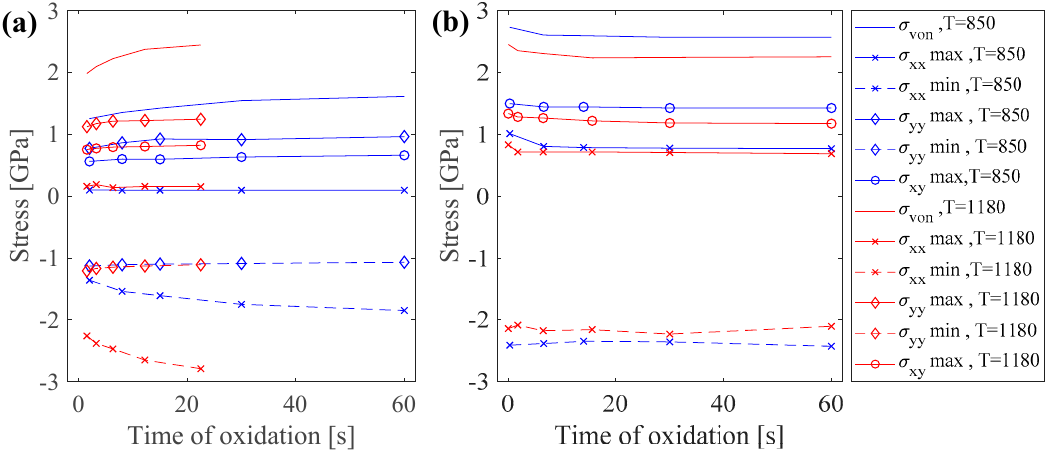
Figure 5. Variations of stress levels for oxidation at 850 °C and 1180 °C for ( a ) planar oxidation, and ( b ) sharp corner oxidation.